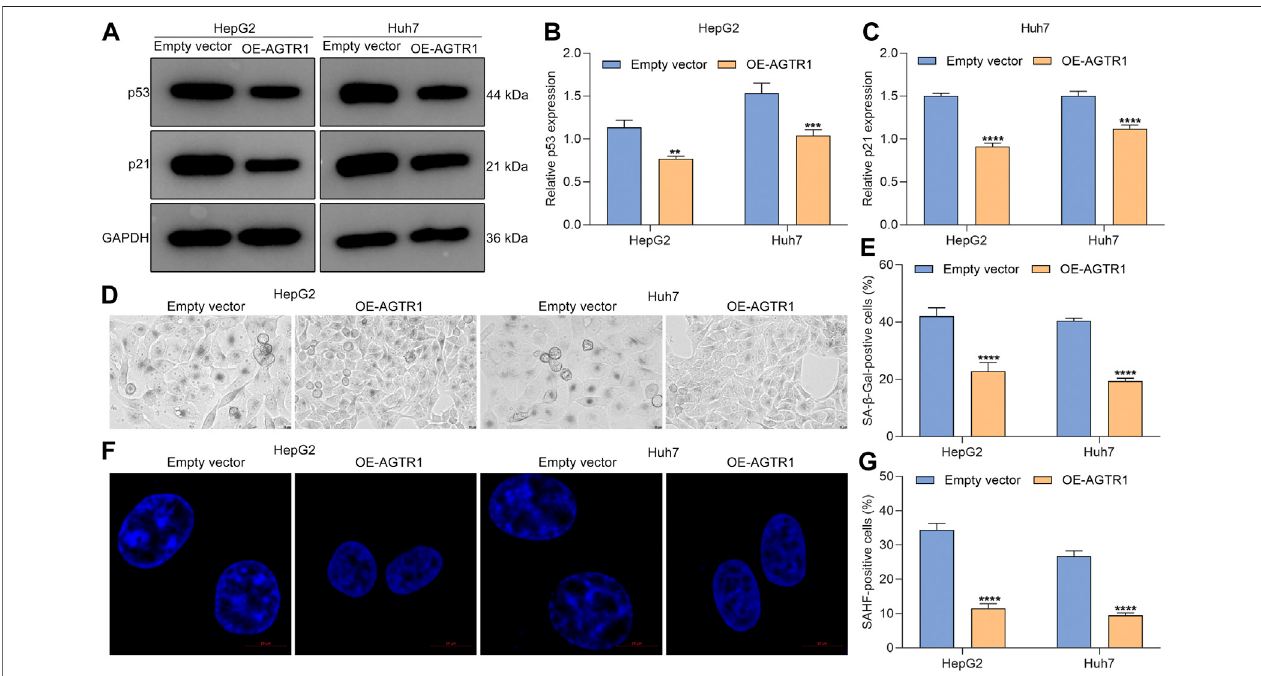
FIGURE 4 | Upregulated AGTR1 weakens cellular senescence of sorafenib-treated HCC cells. (A – C) p53 and p21 protein expression in sorafenib-treated HepG2 along with Huh7 cell lines under AGTR1 lentivirus transduction. (D,E) SA- β -Gal activity of HCC cell lines with AGTR1 lentivirus transduction. Scale bar, 10 μ m. (F,G) SAHF activity of HCC cell lines with AGTR1 lentivirus transduction. Scale bar, 10 μ